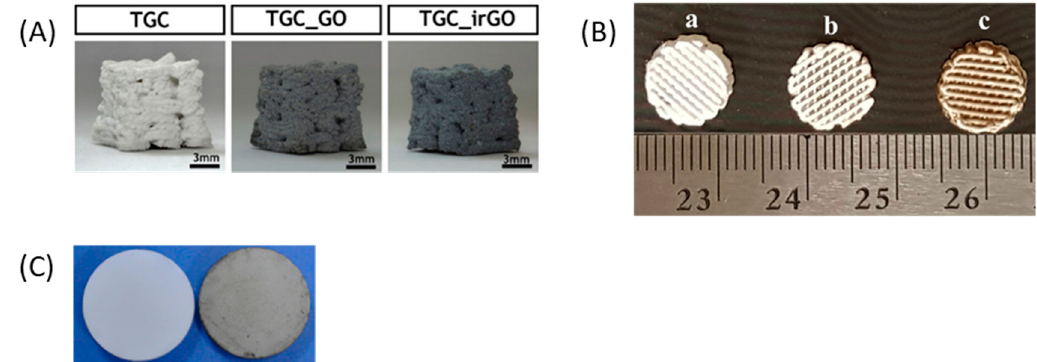
Figure 12. Ceramic parts printed by DIW with and without GO. ( A ) Images of scaffolds produced with GO added to the ink (reprinted from [70], with permission from Elsevier); ( B ) photographs of scaffolds produced (a) without nanomaterials, (b) with 0.25 wt.% and 0.75 wt.% of nanomaterials added by infiltration into the pores (reprinted from [69], with permission from Elsevier); ( C ) Tricalcium phosphate (TCP) disks without and with GO coating (reprinted from [54], with permission from Elsevier).